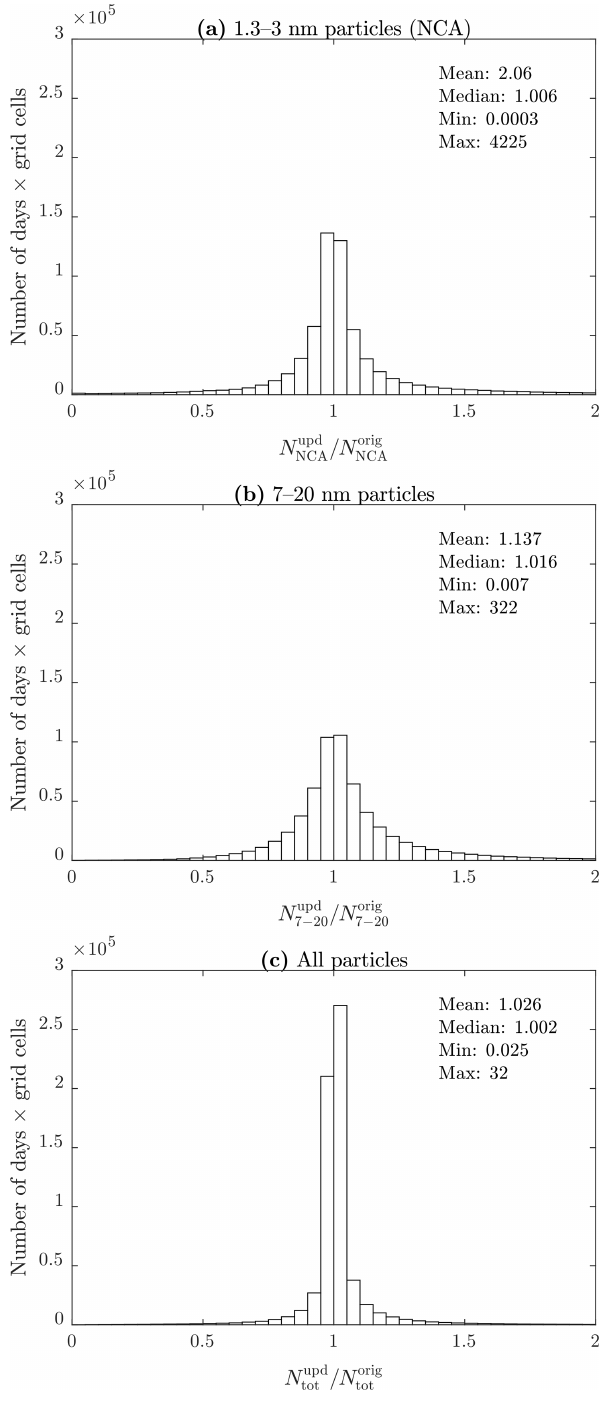
Figure 4. Histograms for grid-cell-separated ratios of daily means of (a) the NCA concentration ( N NCA ), (b) the concentration of 7– 20nm particles ( N 7 − 20 ), and (c) the total particle concentration ( N tot ) simulated with the updated and with the original emission inventory. Statistics are also presented numerically on the